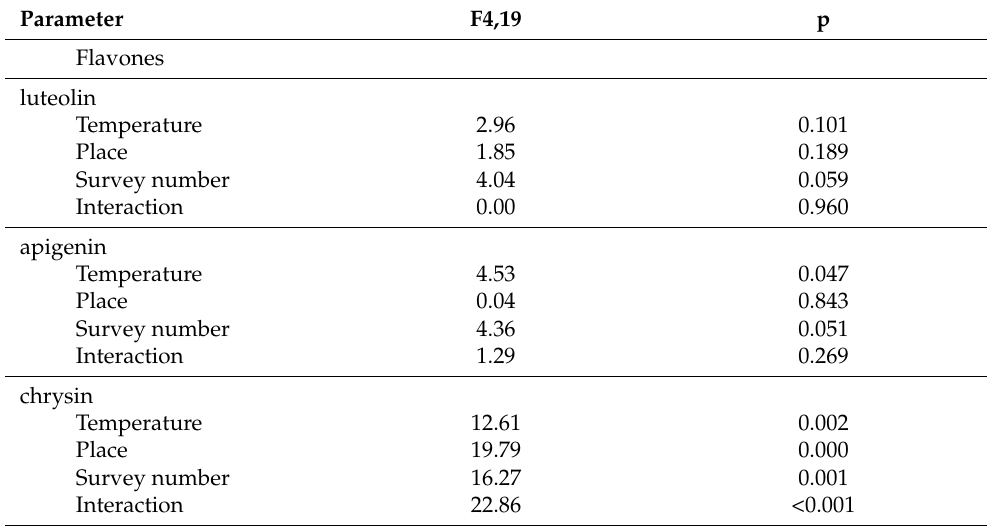
Table 6. The effects of temperature, place, survey number and interaction between studied parameters on level of flavones in V. opulus (GLM, normal error